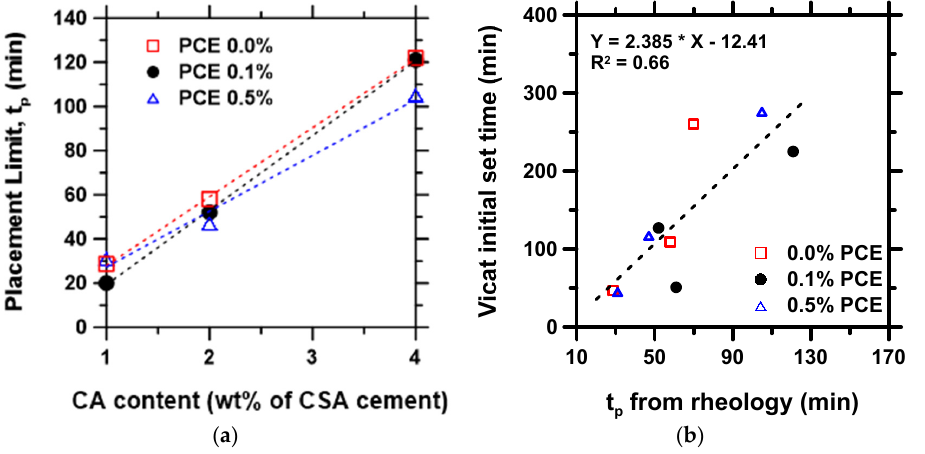
Figure 5. Placement time, 𝒕 𝒑 , of CSA cement paste: ( a ) evolution of 𝒕 𝒑 as a function of admixture dosage, and ( b ) variation in initial time of set with rheology-based 𝒕 𝒑 .